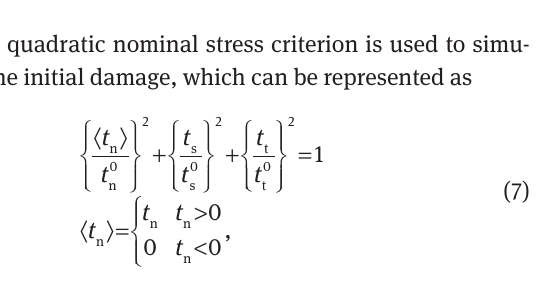
Figure 6: The stress-strain curves of the micromechanical model and the macroscopic experiment under longitudinal compressive loading.